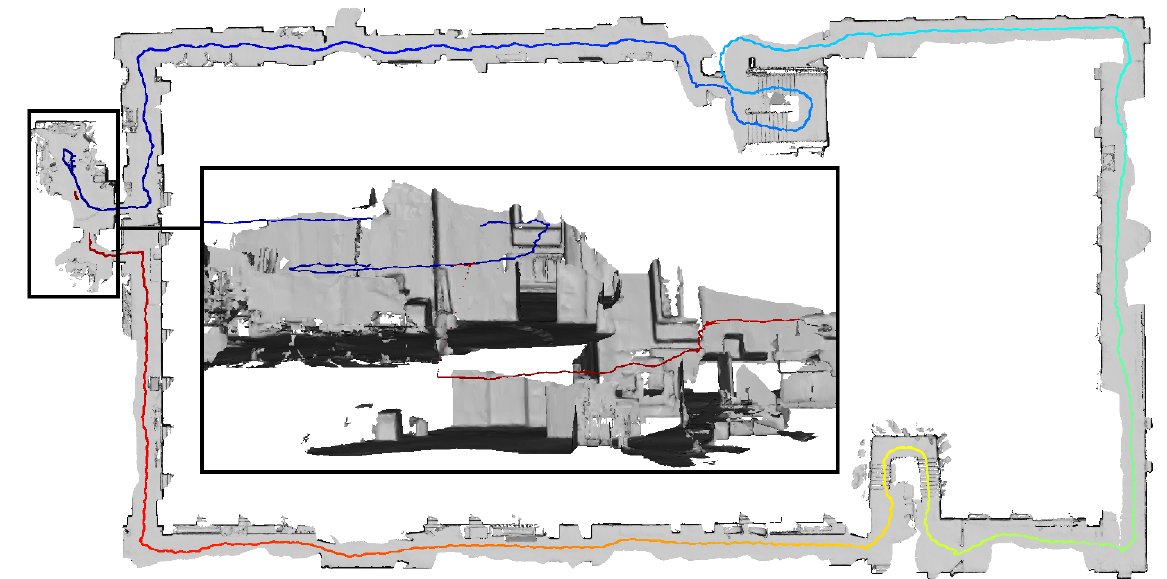
Figure 15. Closed trajectory of a total length of 287m. The color represents time. The trajectory starts at blue and ends at red. The positional error caused by drift amounted to 2.39m upon re-entering the room.